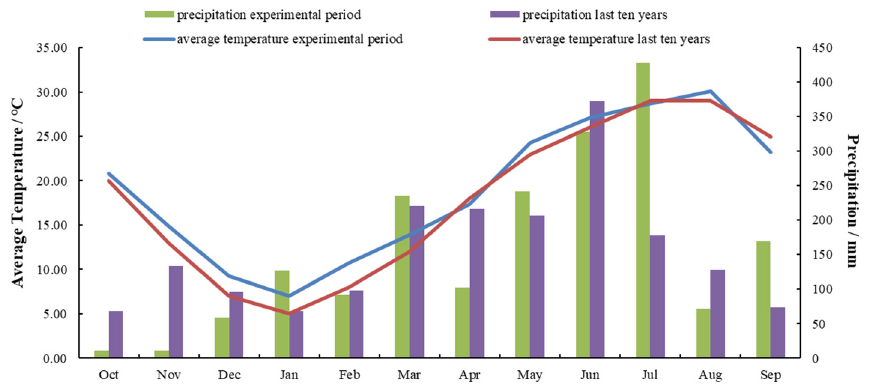
Figure 2. Meteorological data of the experimental